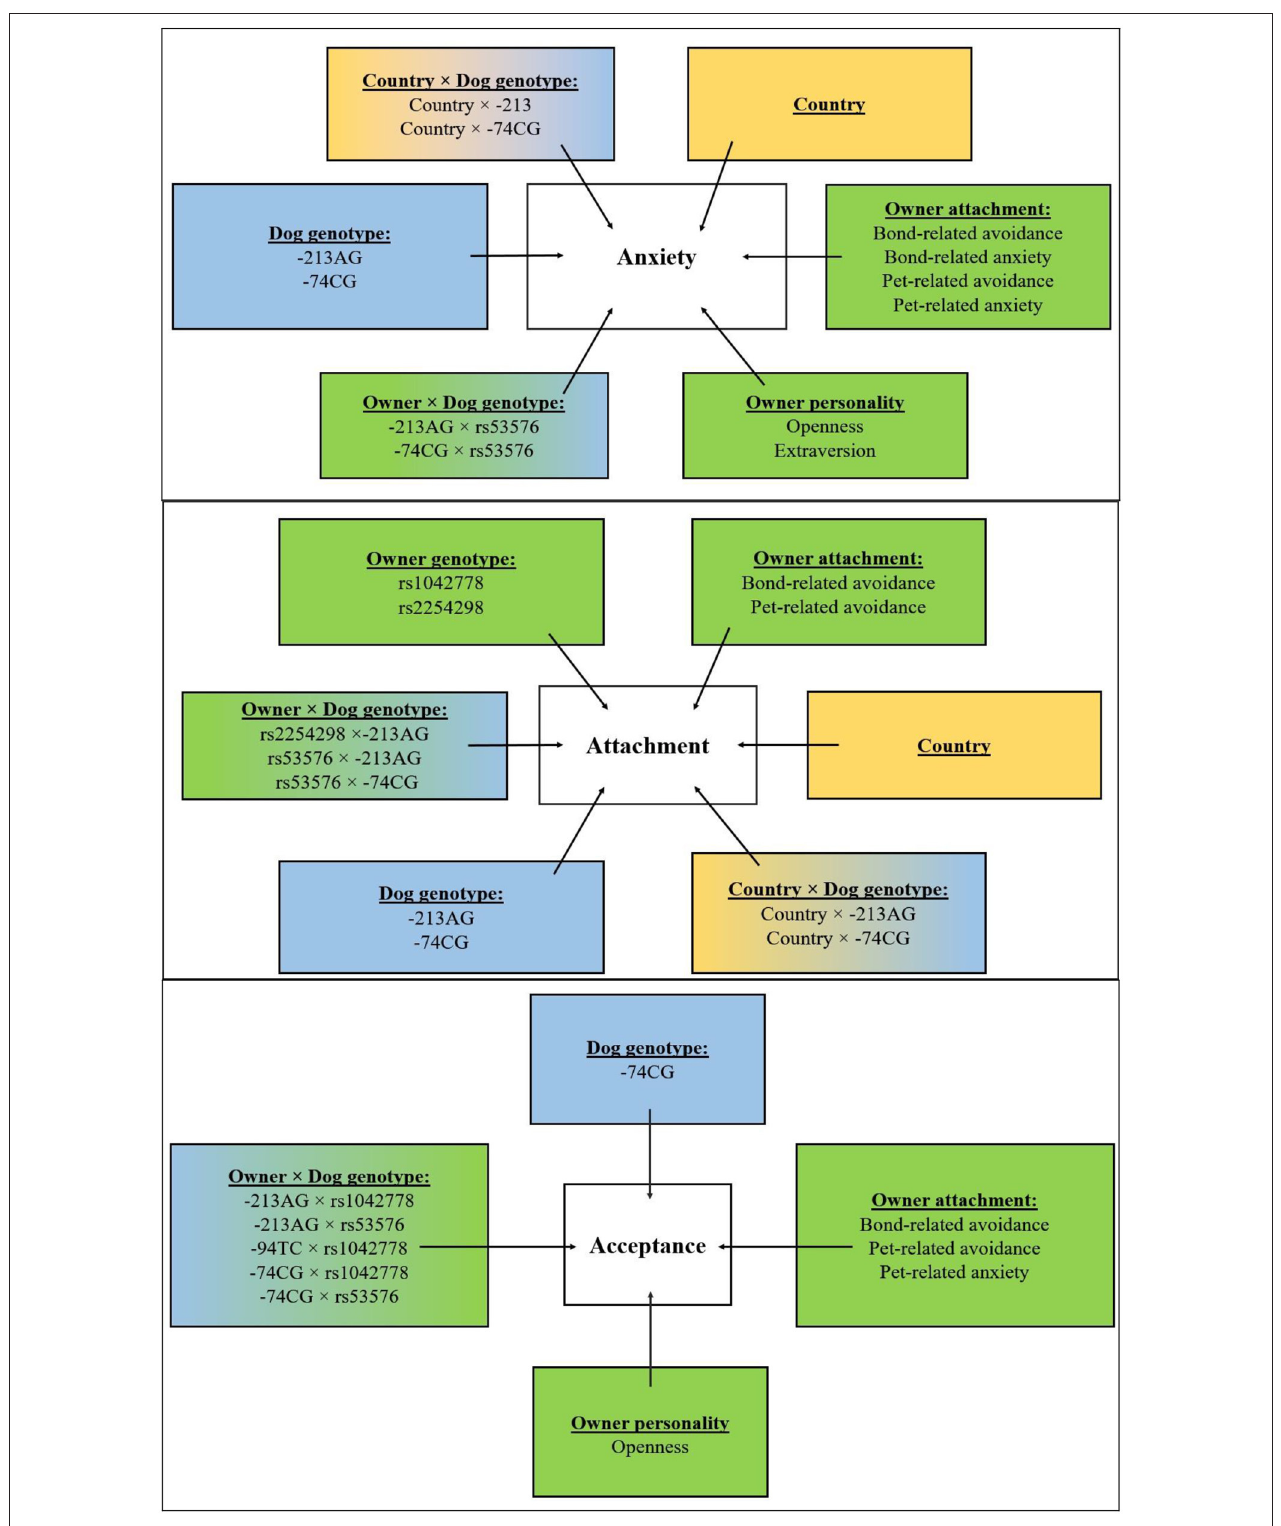
FIGURE 3 | Overview of the results. Effects of country (yellow boxes), environmental (green boxes), and genetic (blue boxes) associations of dogs’ behavior (attachment, anxiety, and acceptance composite scores) and their interactions.